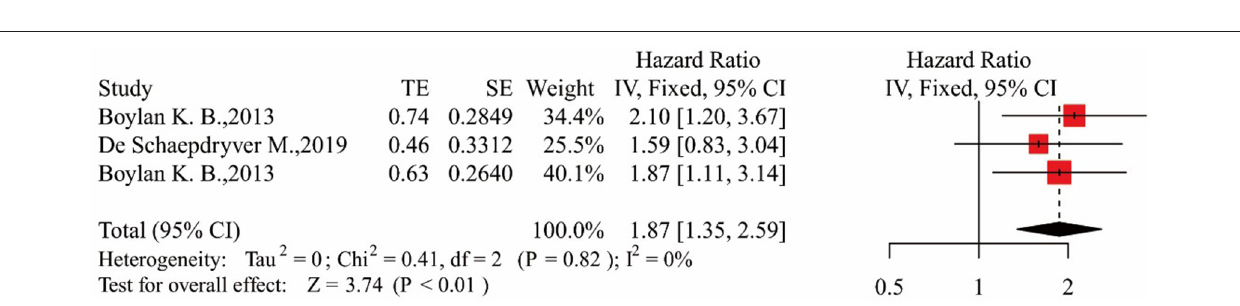
FIGURE 5 | Forest map showing the relationship between pNfH levels and